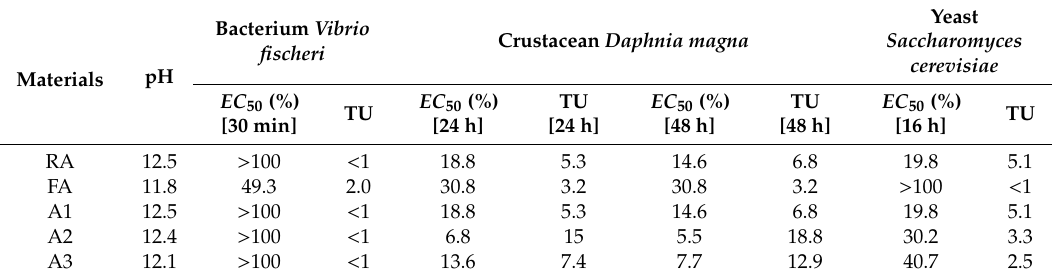
Table 8. Ecotoxicological characterization